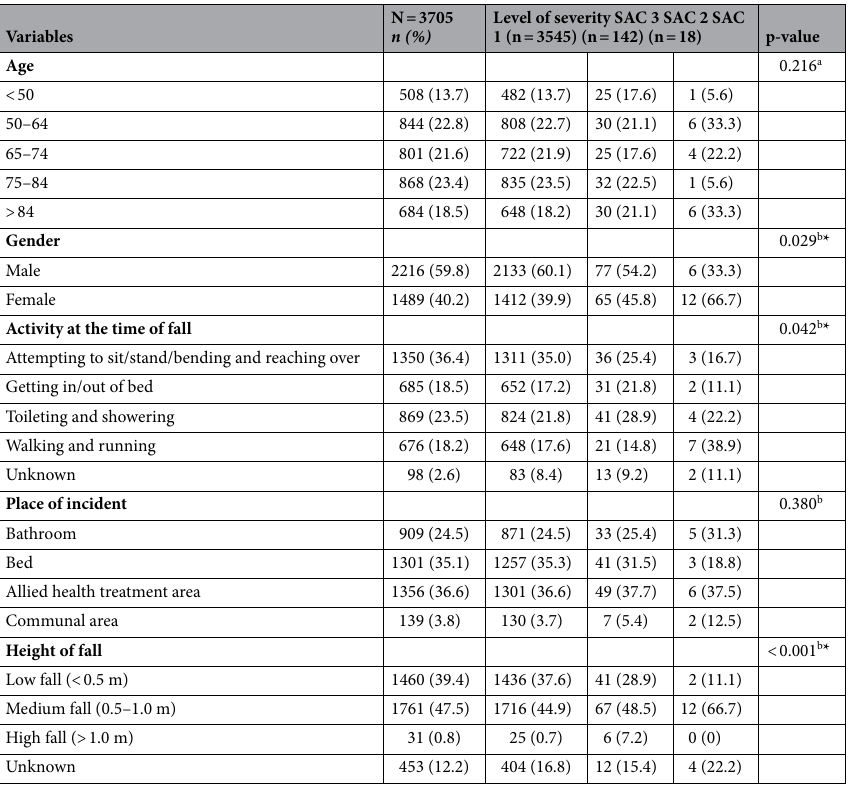
Table 1. Comparison of demographic and environmental characteristics and the severity level of fall. *Denotes significant association at 5% level of significance. a Likelihood Ratio test. b